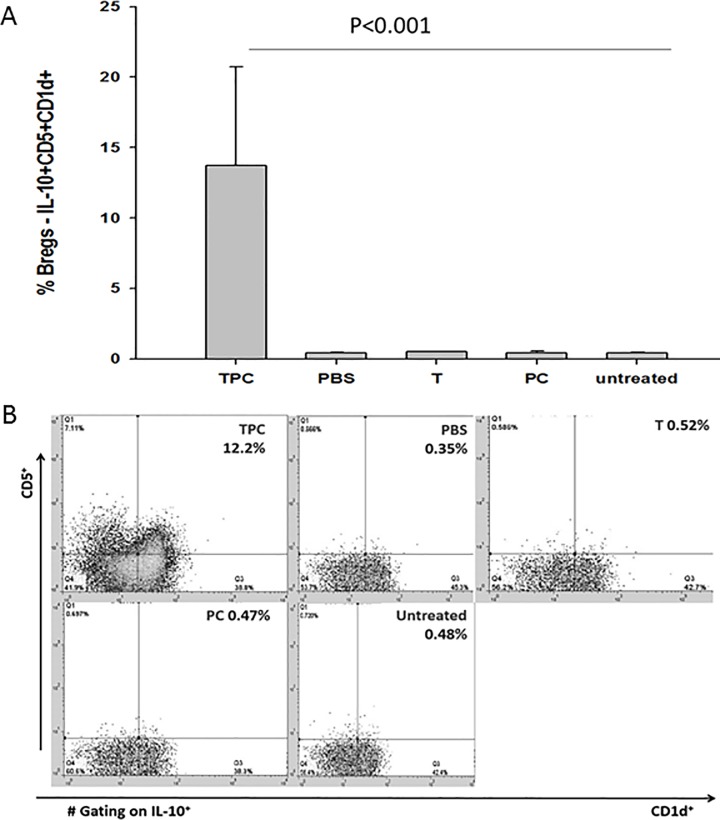
B10 regulatory cells increase in isolated splenocytes of TPC-treated CIA mice.[A] The data are presented as percentage of Breg cells–IL-10+CD5+CD1d+ increase in isolated splenocytes derived from tuftsin- phosphorylcholine (TPC), PBS, tuftsin (T), phosphorylcholine (PC), and untreated CIA mice (n = 10). Values are mean ± SD, P < 0.001. [B] Representative flow cytometry analyses of Breg cells–IL-10+CD5+CD1d+ (gated on IL-10+) in isolated splenocytes derived from CIA mice treated with TPC, PBS, T, and PC, as well as untreated CIA mice.